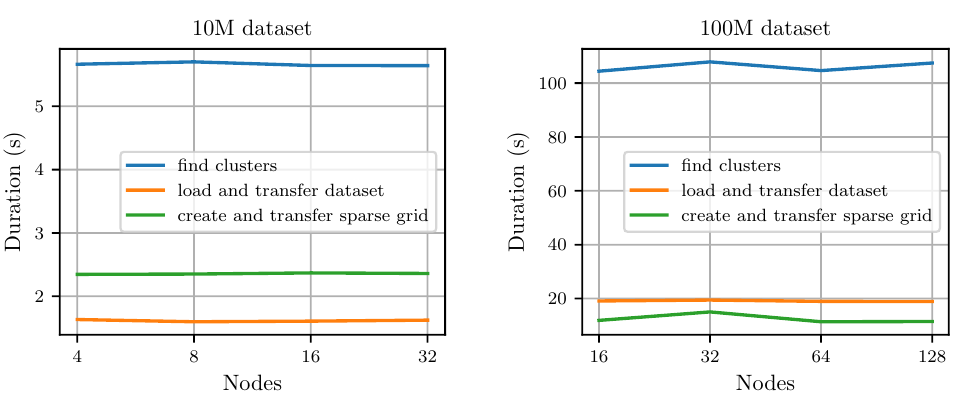
Figure 8. Strong scaling results for both the 10M (left graphs) and 100M (right graphs) Gaussian dataset on Hazel Hen. Figure 8a,b show duration and performance of the major computed kernels and the application as a whole. The duration of other (minor) tasks is shown in Figure